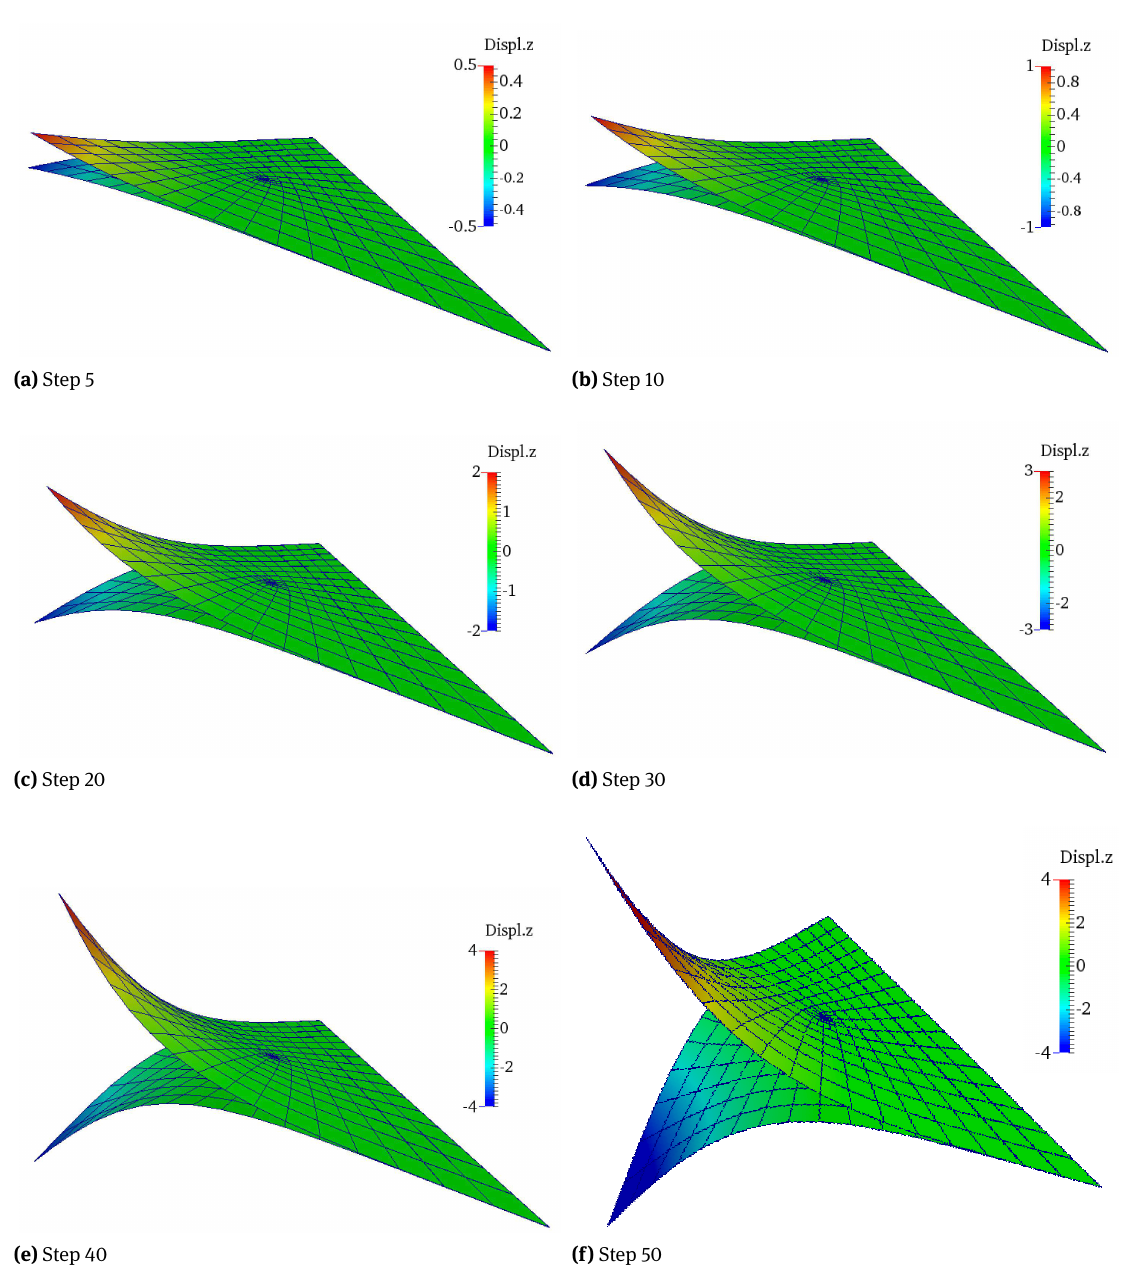
Figure 23: 3D thin-walled triangular laminates with T-Splines: deformed shapes and displacement contours for different time